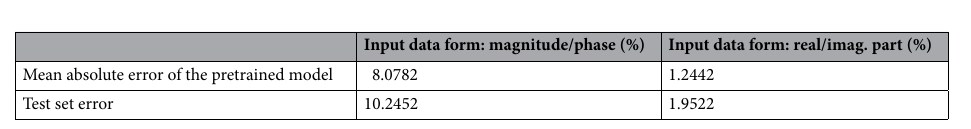
Table 2. Training